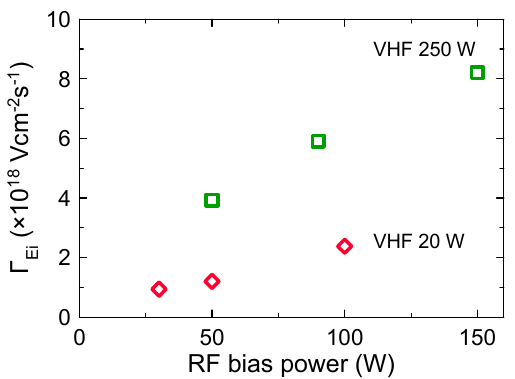
Figure 3. Ion bombardment energy fluxes Γ E i as a function of RF bias powers. Diamonds ( ◇ ) and squares ( □ ) correspond to 20 and 250 W in VHF power, respectively.